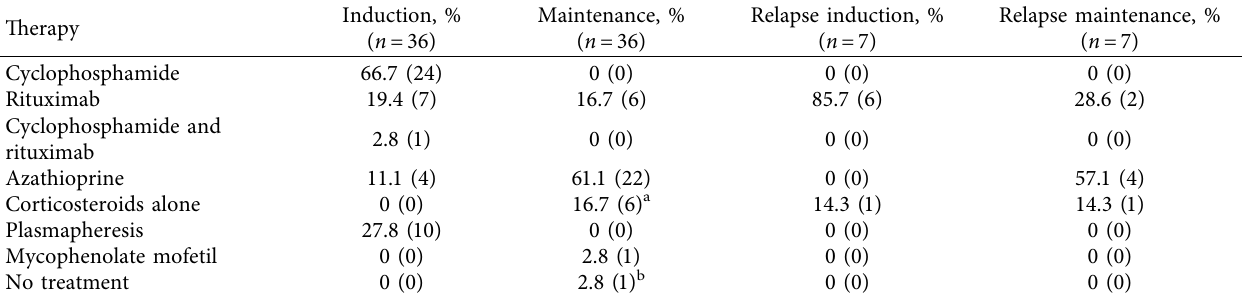
Table 3: Summary of induction and maintenance